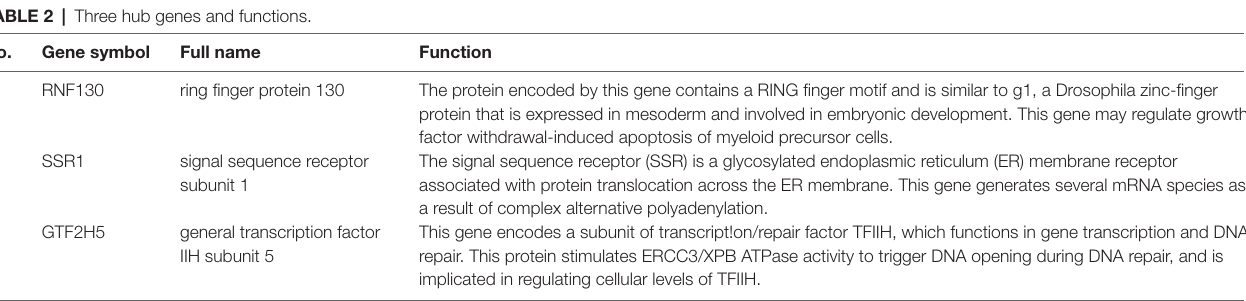
TABLE 2 | Three hub genes and